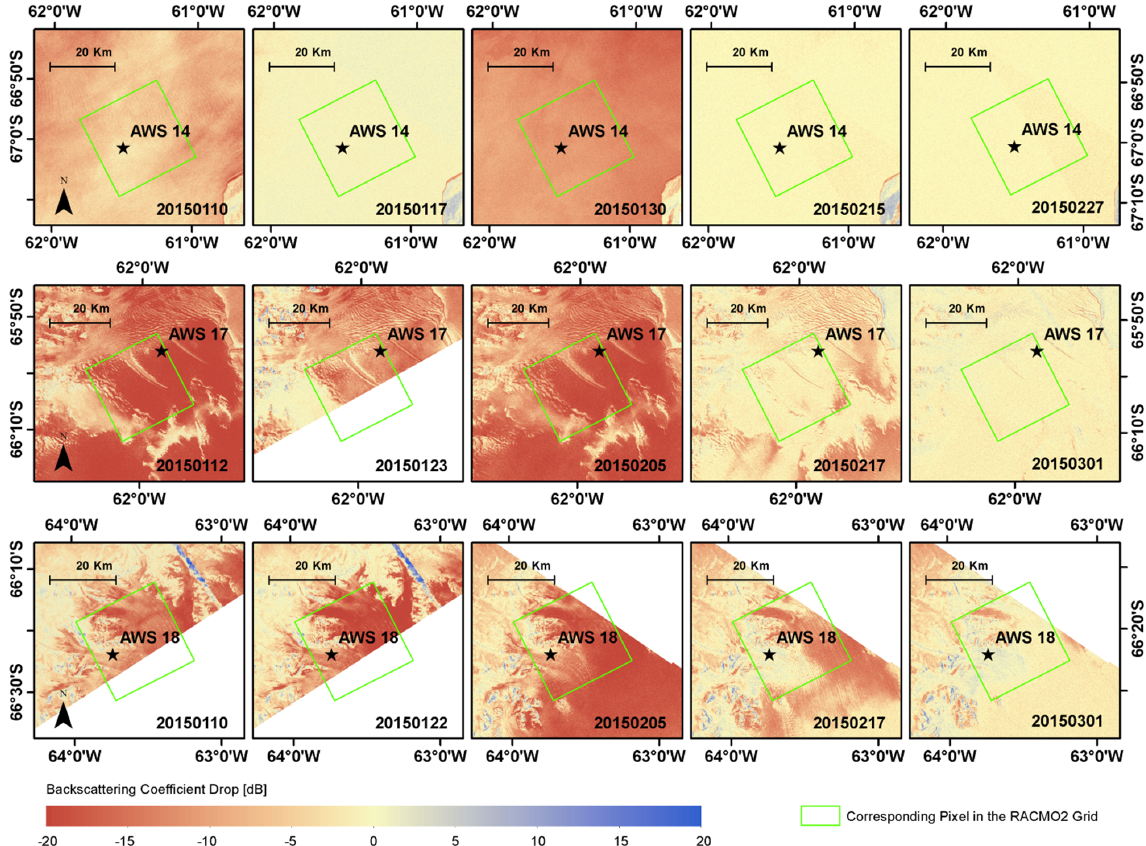
Figure 8. Spatiotemporal patterns of surface melt, represented by the drop in the backscattering coefficient in Sentinel-1 imagery, in automatic weather station (AWS) 14, AWS 17, and AWS 18 observations between January and March in 2015 as well as their corresponding regional atmospheric climate model version 2.3p2 (RACMO2)